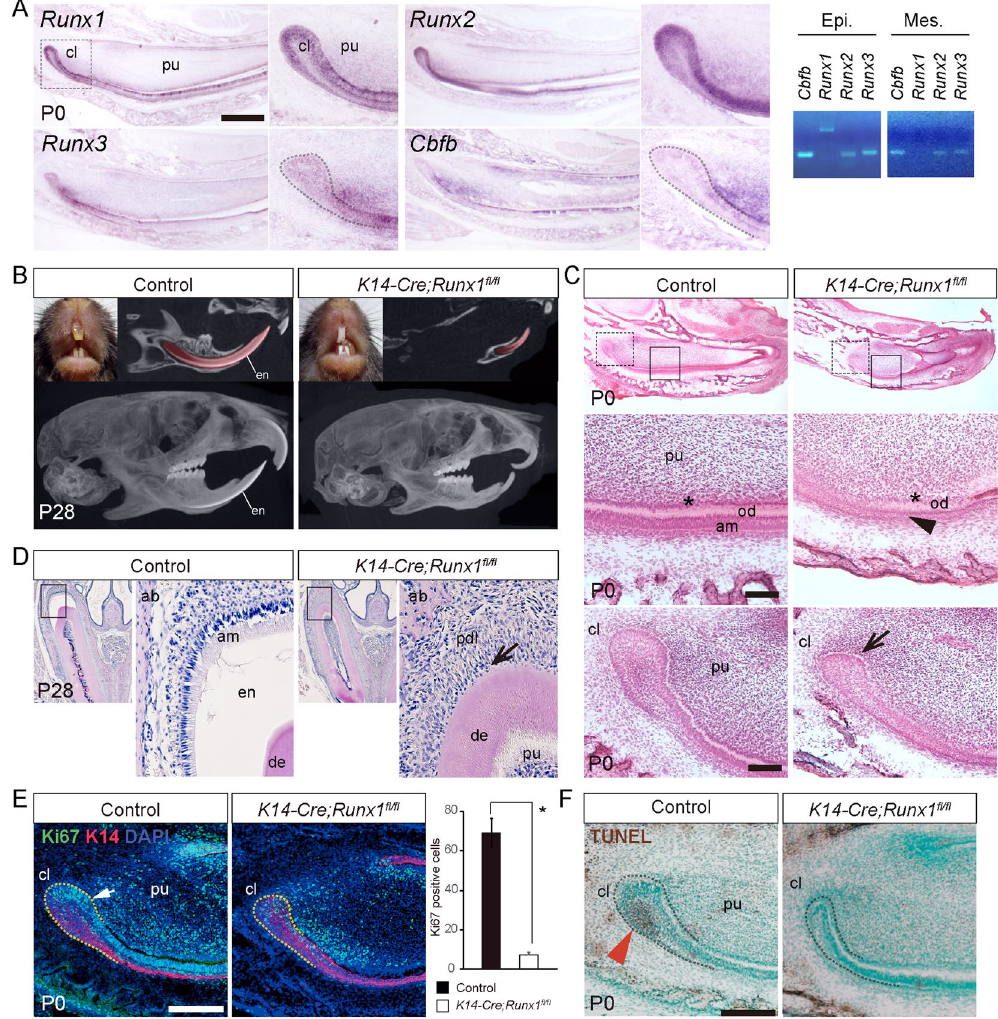
Figure 1. The incisor phenotype of K14-Cre/Runx1 fl/fl mice. ( A ) Expression of Runx1, Runx2, Runx3 and Cbfb in sagittal sections of P0 incisors and gene expression was confirmed by RT-PCR from dissected epithelium and mesenchyme. Runx1 transcripts were detected in the dental epithelium. In the cervical loop, Runx1 was expressed in the basal epithelial cells (inner enamel epithelium) and the outer enamel epithelium in the cervical loop. Scale bar: 500 μ m. ( B ) The Runx1 mutant incisors demonstrated a column shape and lost their transparency, although the control incisors developed fine edged shape. In the micro-CT analysis, the incisors of the Runx1 mutant mice had an abnormal shape, extreme shortening and enamel defects. On the other hand, significant differences were not detected in the molar root length or morphology. ( C ) HE staining of incisor sagittal sections from P0 Runx1 mutant mice confirmed the shortening of the Runx1 mutant incisors. At higher magnification, hypoplasia of the cervical loop (arrow) was evident and ameloblast precursors lost their polarity and had a flattened shape in Runx1 mutants (arrowhead). Scale bar: 100 μ m. ( D ) HE staining of incisor frontal sections from P28 Runx1 mutant mice confirmed the lack of enamel matrix formation. At higher magnification, enamel matrix was not evident between the dentin and the periodontal ligament (arrow) in the upper incisors of Runx1 mutants. ( E ) Double immunostaining for Ki67 (green) and K14 (red) revealed that the epithelium in the cervical loop of the Runx1 mutant was significantly less proliferative (arrow). Nuclei were counterstained with DAPI (blue). Scale bar: 200 μ m. ( F ) TUNEL staining revealed that the number of TUNEL-positive cells was significantly reduced at the cervical loop of the Runx1 mutant incisors (arrowhead). cl, cervical loop; pu, dental pulp; en, enamel; am, ameloblasts; od, odontoblasts. Scale bar: 200 μ